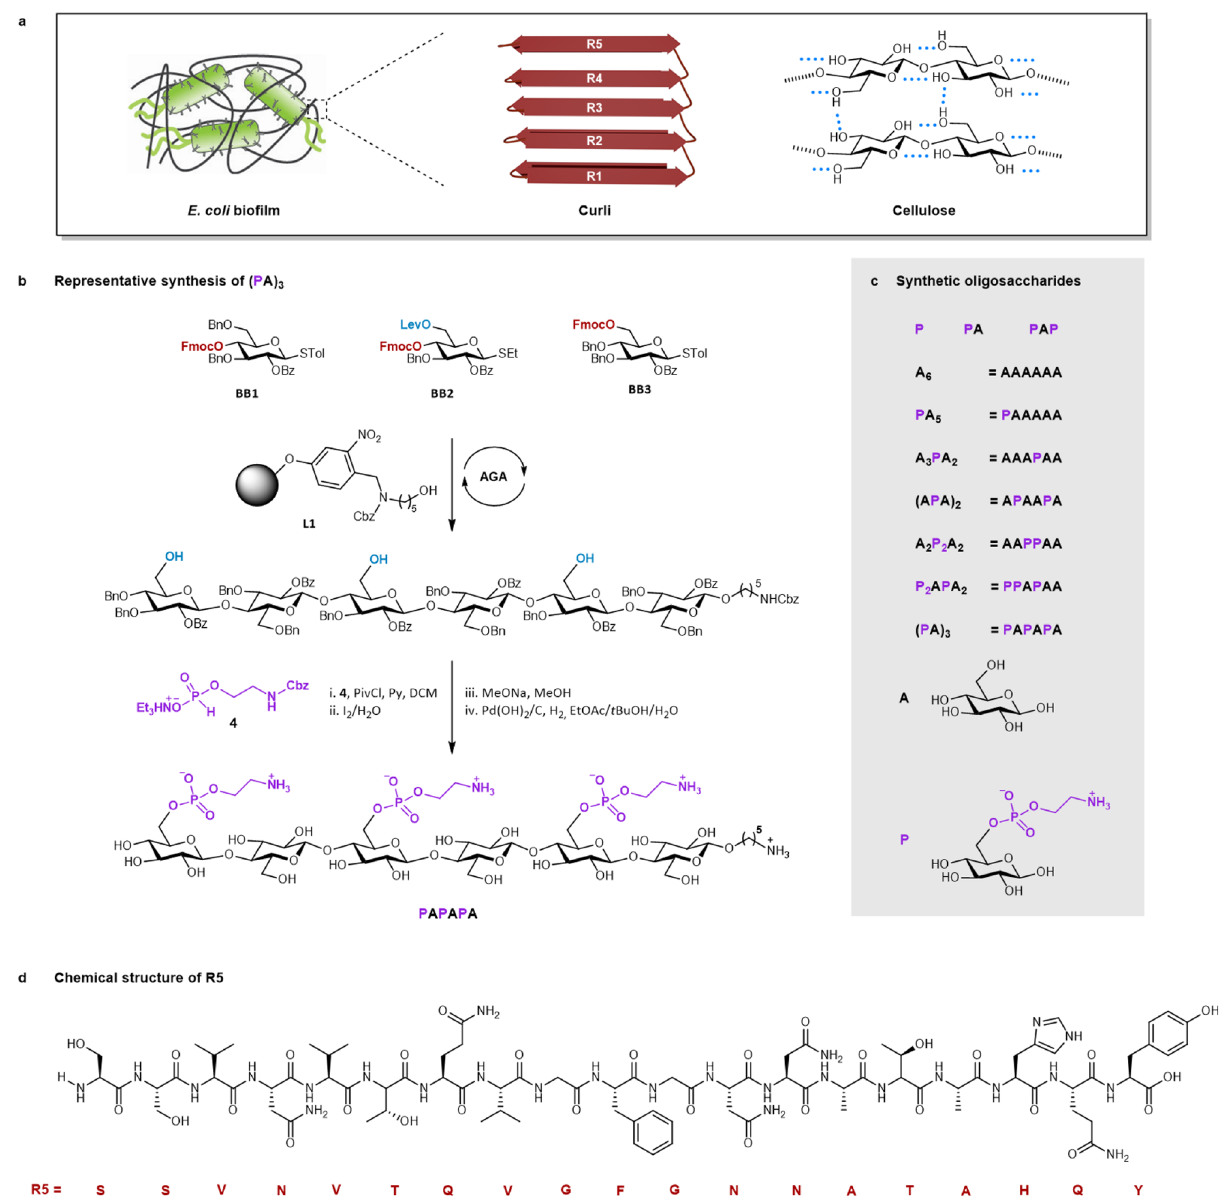
Fig. 1 E. coli bio fi lm and synthesis of its representative matrix components. a Cartoon representation of E. coli bio fi lm. b Representative synthesis of a pEtN hexasaccharide. AGA includes cycles of glycosylation, capping, and Fmoc deprotection. A fi nal Lev deprotection liberates the hydroxyl groups that are functionalized in post-AGA steps. Reaction conditions for AGA are reported in the SI. PivCl = pivaloyl chloride, py = pyridine, MeONa = sodium methoxide. c Collection of oligosaccharides synthesized in this work. d Chemical structure of the peptide R5